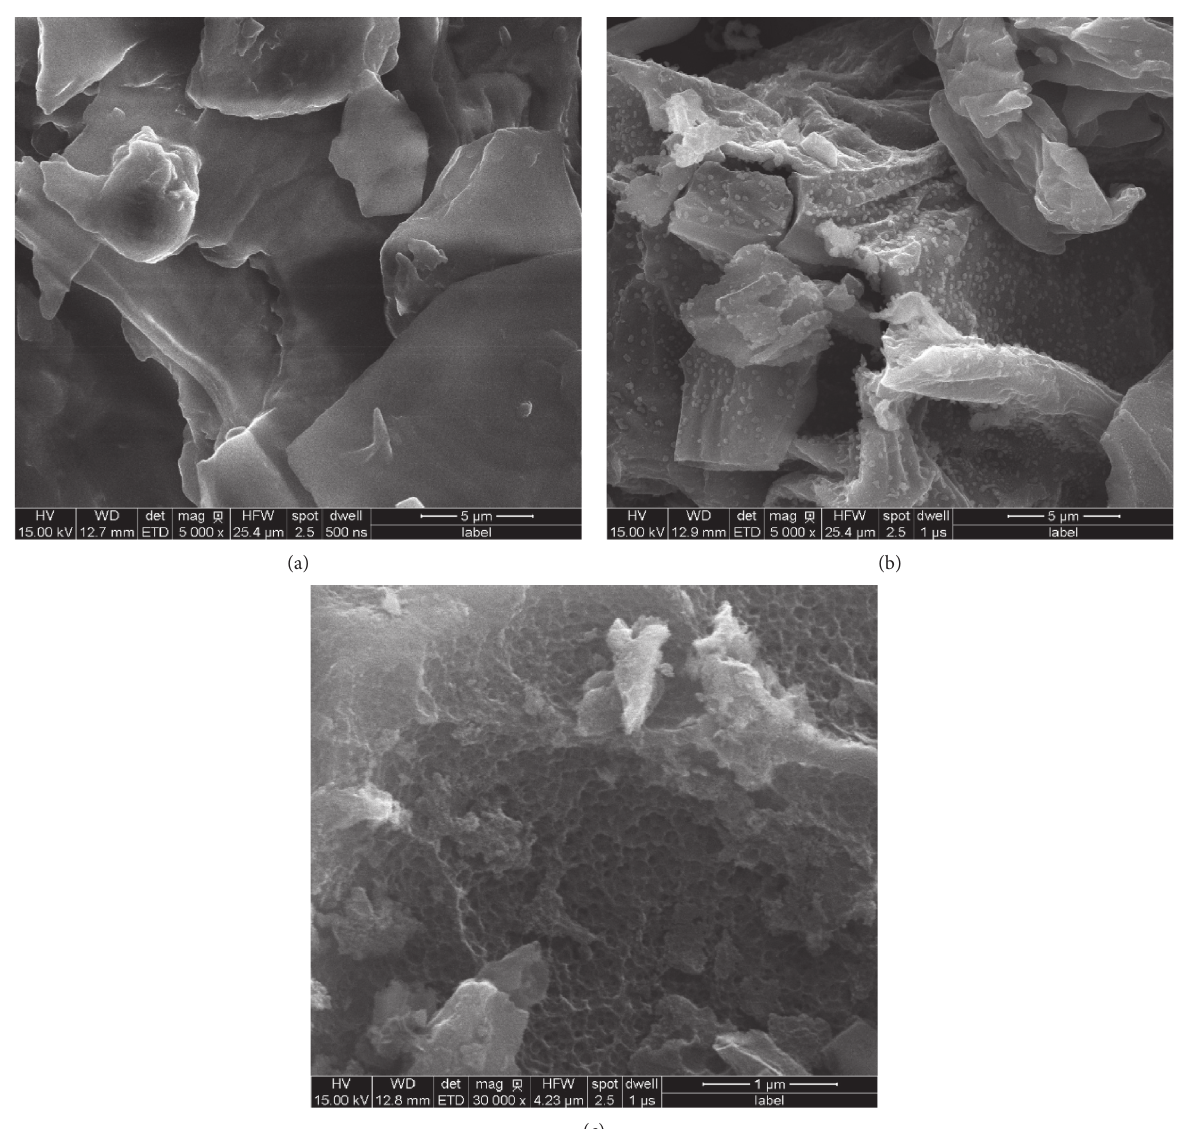
Figure 3: SEM of (a) pomelo peel, (b) carbonized pomelo peel, and (c) PAC850-1-3.